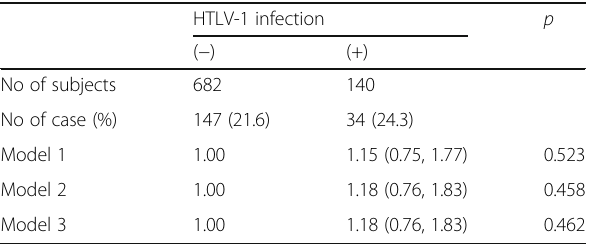
Table 2 Odds ratios (ORs) and 95% confidence intervals (CIs) for advanced periodontitis in relation to human T cell leukemia virus-1 (HTLV-1) infections